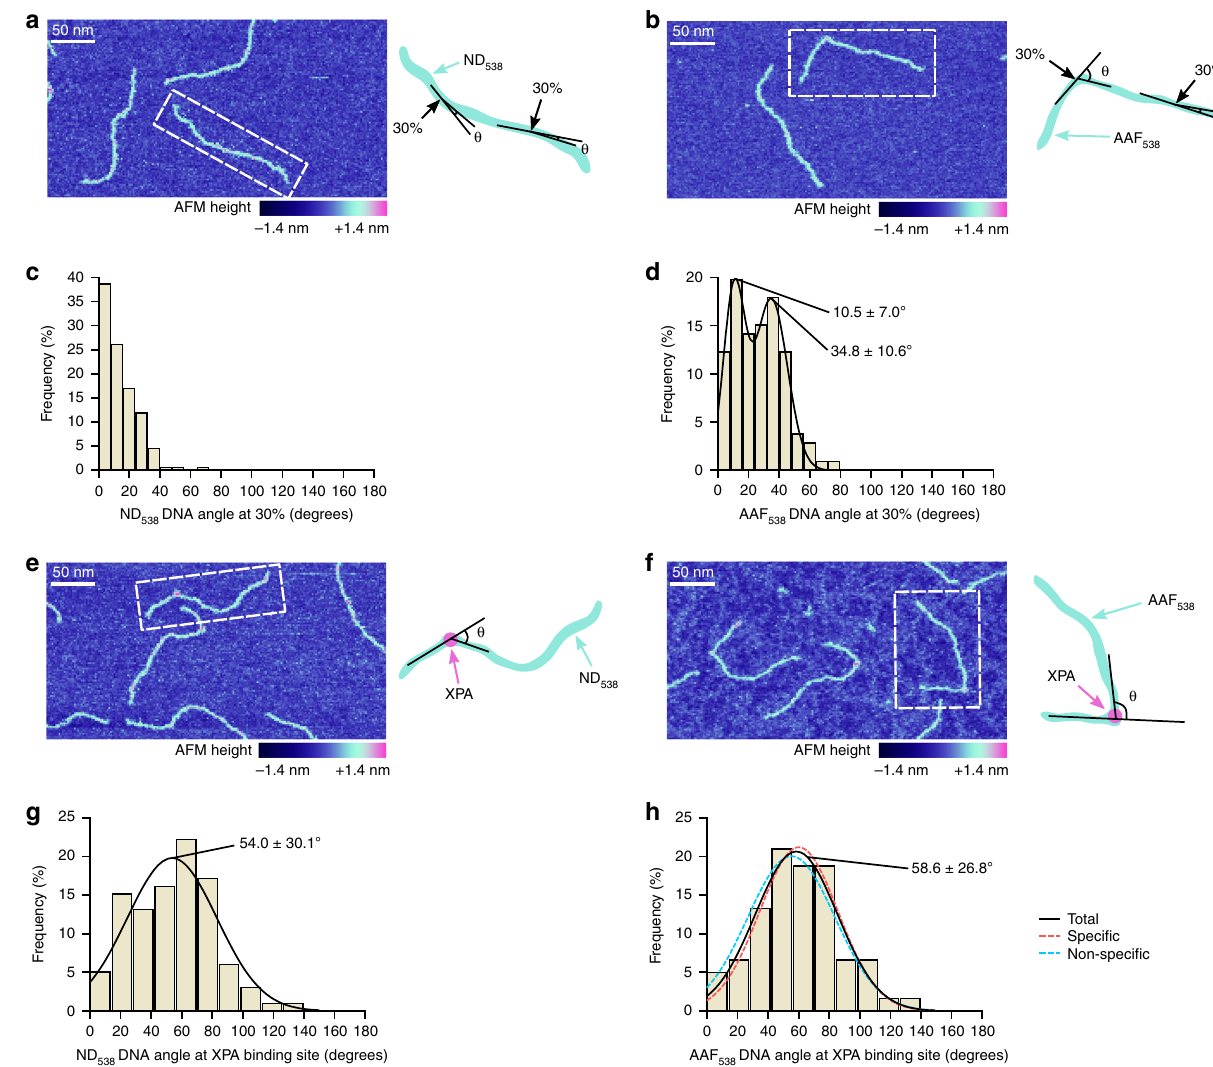
Fig. 4 dG-C8-AAF bends DNA ∼ 35° and XPA bends DNA ∼ 60°. a , b Representative AFM image of free 538 bp non-damaged DNA ( a , ND 538 ) or free 538 bp DNA with a single dG-C8-AAF adduct at 30% from one end ( b , AAF 538 ). Dashed white line indicates the example in the cartoon to the right. Angles were measured at sites 30% of the total DNA contour length from each end and are reported as the θ angle (supplement to internal DNA angle). c Histogram of the inherent DNA bend angle of non-damaged DNA ( n = 176 angles). d Histogram and double Gaussian fi tting of the inherent DNA bend angle of AAF-adducted DNA ( n = 106 angles). Each peak of the Gaussian is labeled as mean ± s.d. e , f Representative AFM image of XPA bound to ND 538 ( e ) or AAF 538 ( f ). The dashed white line indicates the example in the cartoon to the right. Angles were measured at sites of bound XPA and are reported as the θ angle. g Histogram and Gaussian fi tting showing the distribution of DNA bend angles at all sites of internally bound XPA on ND 538 ( n = 99 angles). h Histogram showing distribution of DNA bend angles at all sites of internally bound XPA on AAF 538 ( n = 181 angles) with Gaussian fi t (solid black line). Gaussian is labeled as mean ± s.d. Dashed red line, Gaussian fi t to the sub-fraction of angles at XPA sites between 20 and 40% of the DNA contour length ( “ speci fi c, ” n = 116); centered at 60.2° (s.d. 25.7°). Dashed cyan line, Gaussian fi t to the sub-fraction of angles at sites of XPA bound internally but at positions away from the lesion ( “ non-speci fi c, ” n = 65); centered at 55.3° (s.d.